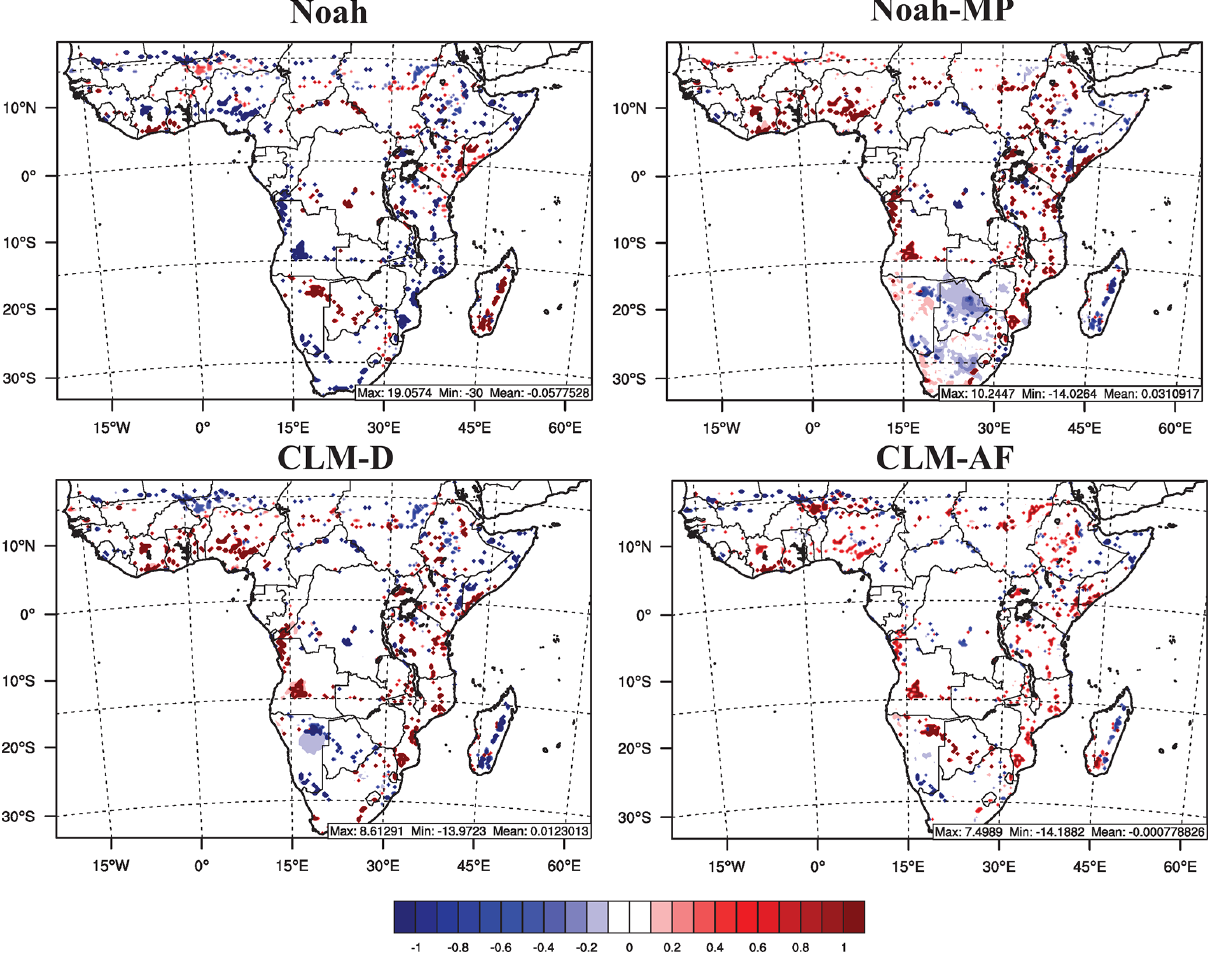
Figure 13. Differences in albedo (%) between LUD and LU01 (LUD-LU01) simulations using Noah, Noah-MP, CLM-D, and